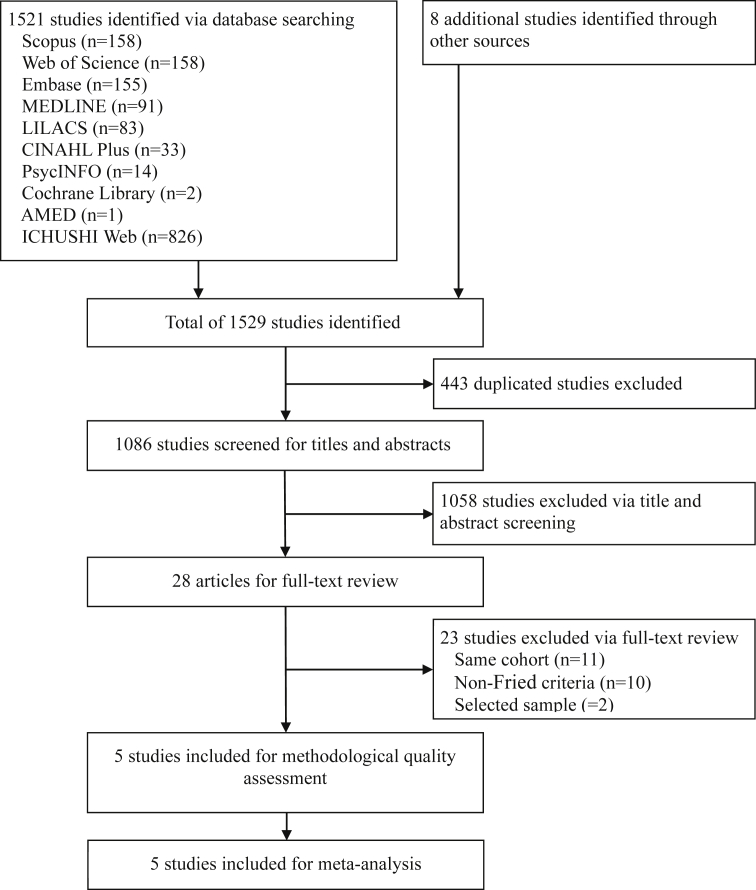
PRISMA flow chart.